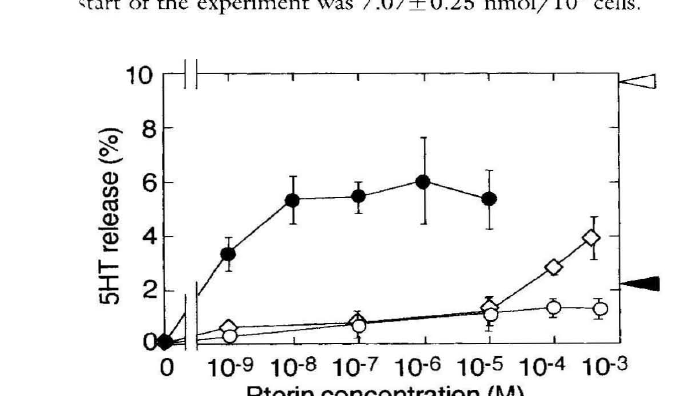
figure 3. Serotonin release by 6RRH., 6SBH 4 and sepia pterin as a ftmction of concentration: Pterins of indicated concentrations were administered to RBL2H3 cells. The cells were prcviously loaded with 100 f..lM serotonin for 6 hours as described in Materials and Methods. Cumulative serotonin release for I hour was measured arrcr ad ministration of 6RBH (closed circle), 6SBH (open cir 4 4 cle), and sepiapterin (open diamond). Cellular serotonin elt the start of the experiment was 6.33±O.23 nmo\jIO" cells. ror comparison, serotonin release on exposure to 30 mM KCI (closed arrow head) and 30 nM A23187 (open arrow head) with the same culmre are